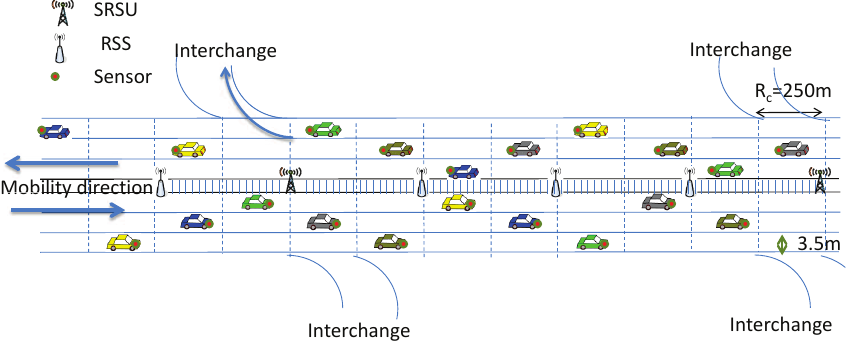
Figure 3. The proposed hybrid smart vehicular ad hoc network (SVANET)